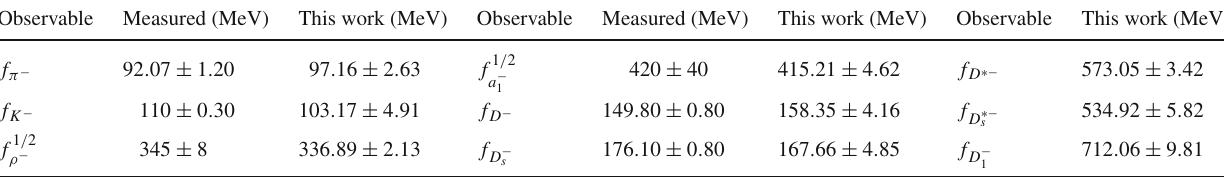
Table 4 Our predictions for the decay constants of nine selected mesons. The measured value are taken from [66,69,70]